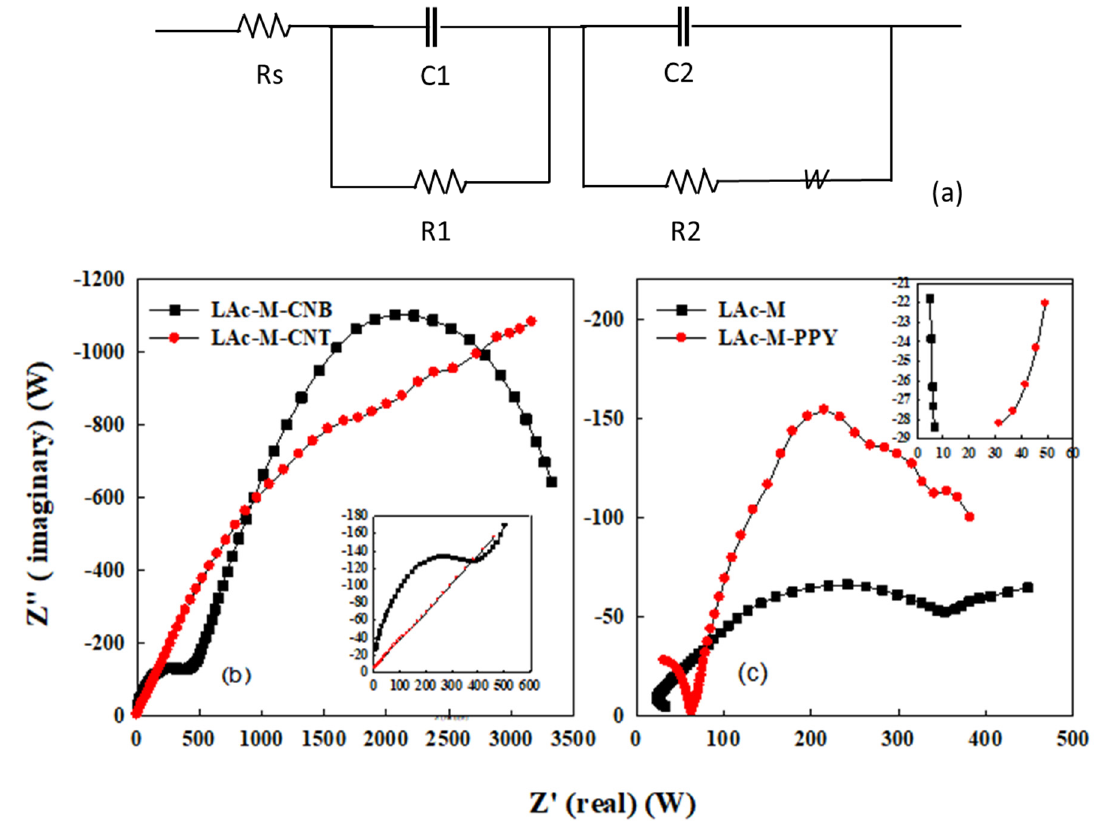
Figure 12. ( a ) Representation of Randle circuit and Nyquist plot for ( b ) LAc-M-CNB and LAc-M-CNT and ( c ) LAc-M-PPY and LAc-M biocathode impedance for